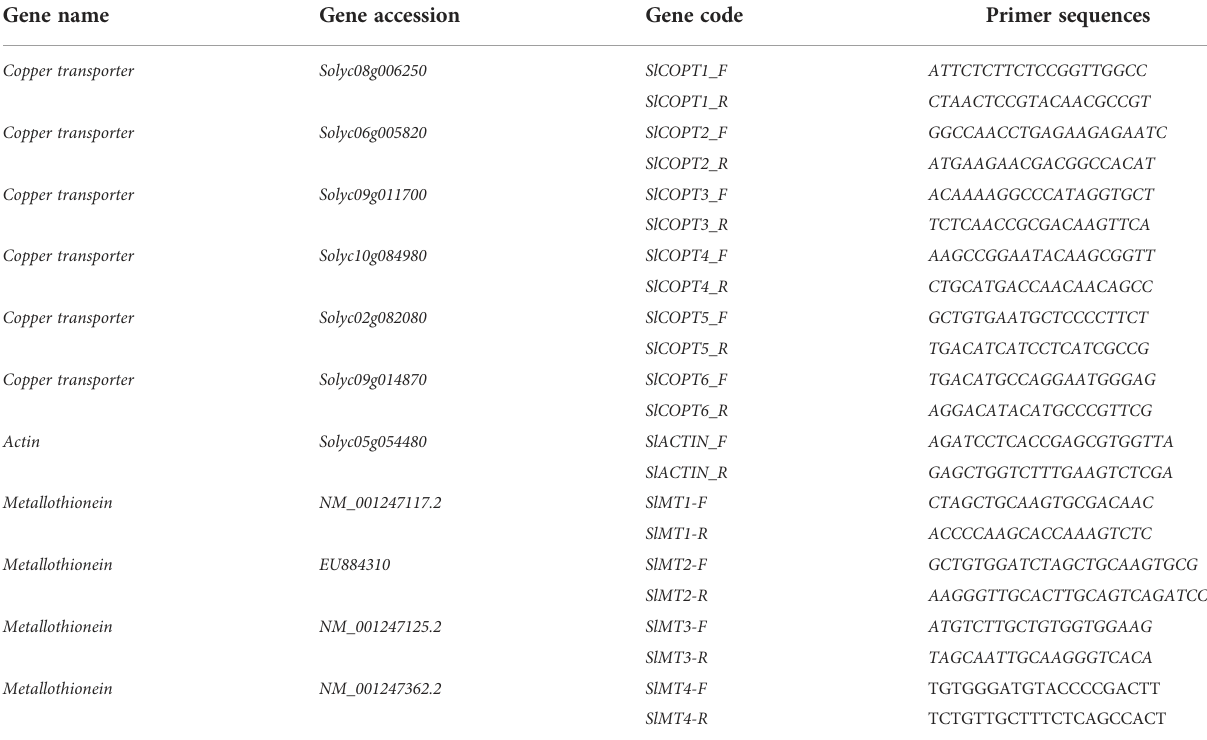
TABLE 1 Primers used for reverse transcription – quantitative PCR